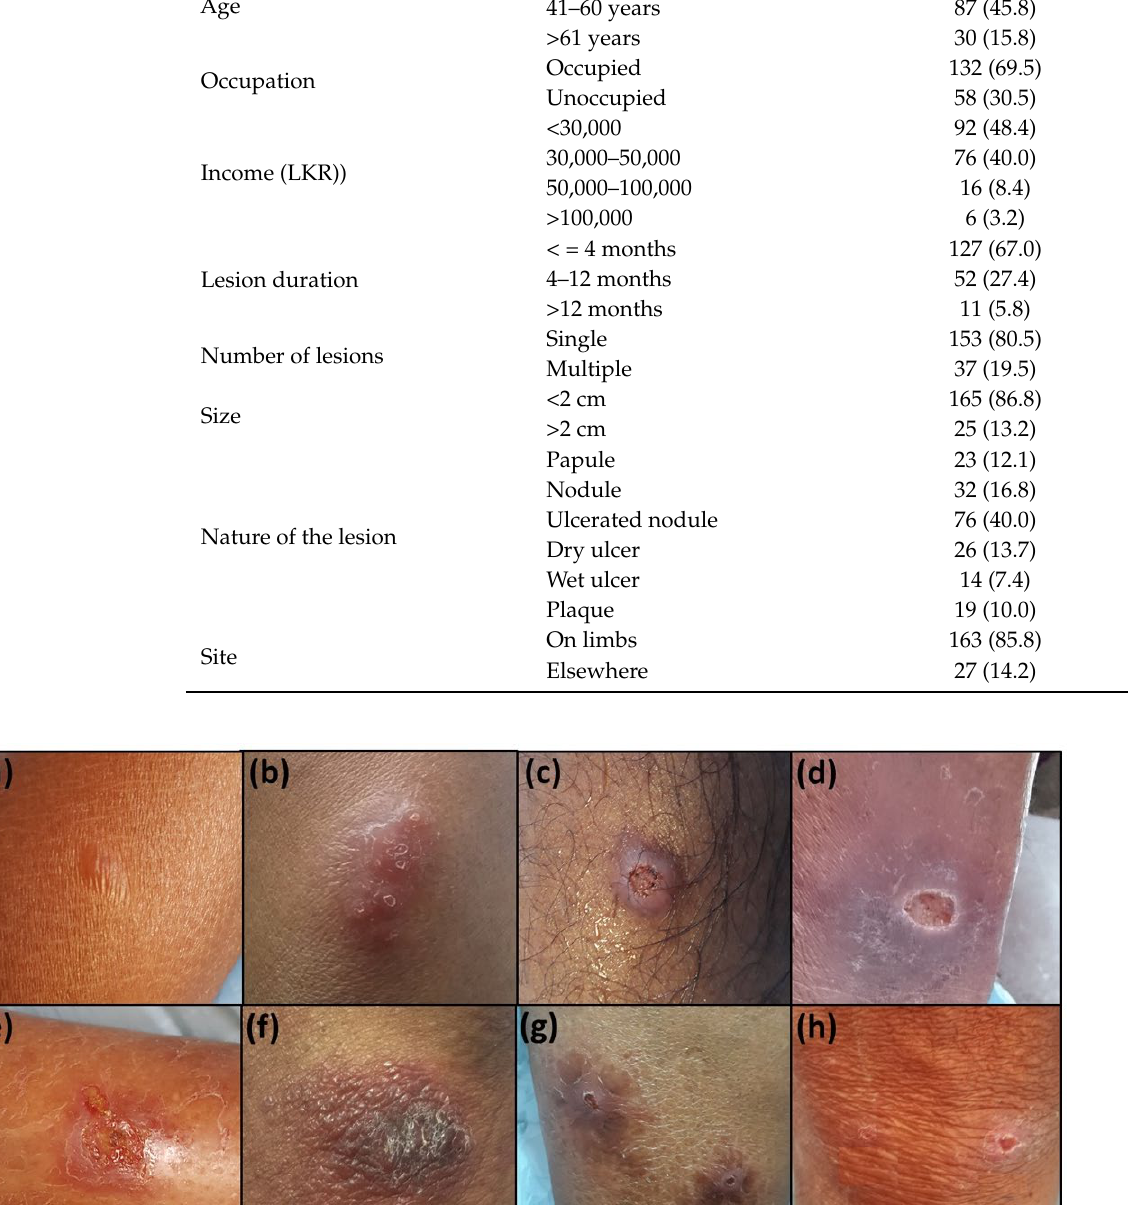
Table 1. Clinical and demographic characteristics of the CL cohort ( n = 190).